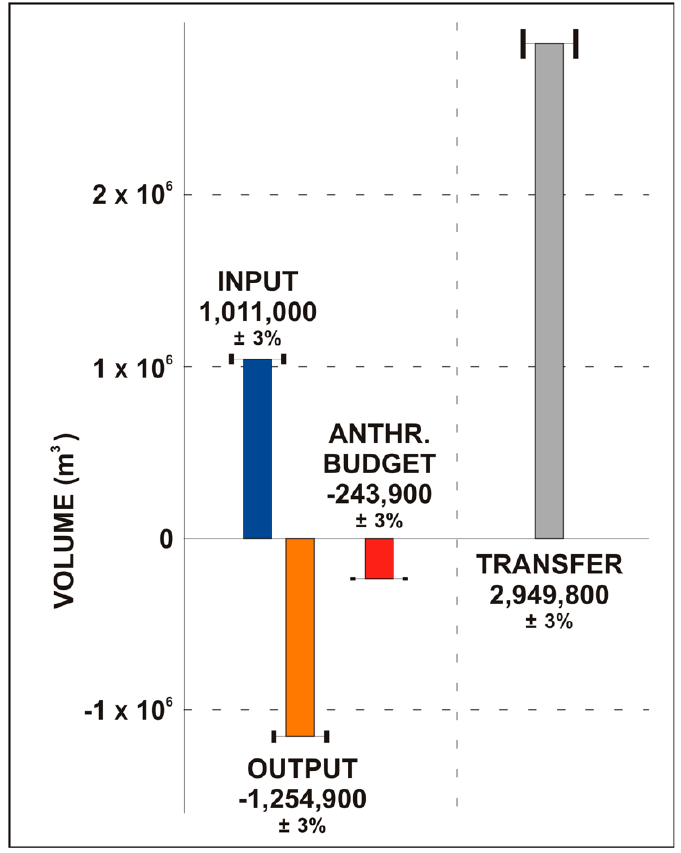
Figure 4. The diagram shows the sum of all the contributions to sediment input, output, and transfer (expressed in m 3 ) in the 1980–2020 timespan. The red column represents the anthropogenic sediment budget, calculated as the algebraic sum of inputs and outputs. The whiskers represent the 3% of uncertainty.